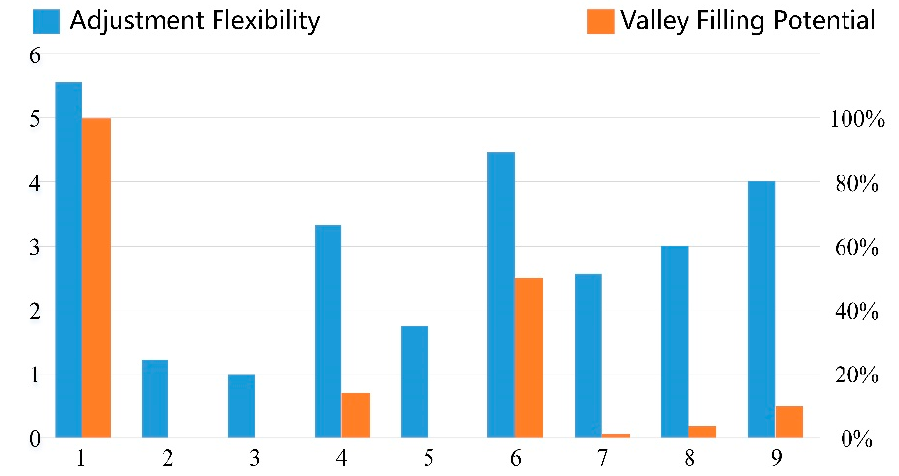
Figure 8. Adjustment flexibility and valley filling potential of different types of loads.